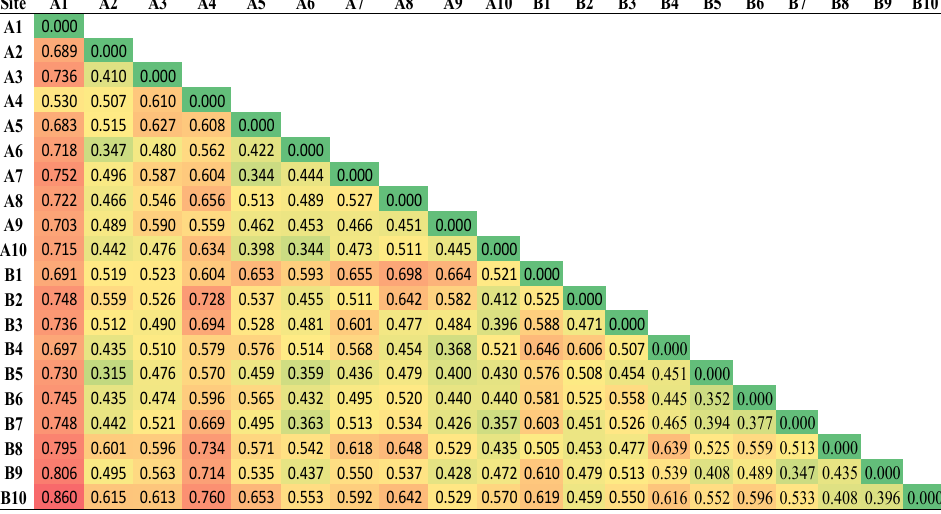
Figure 4. The dissimilarity matrix among the sampled sites of the sediment in both investigated areas.